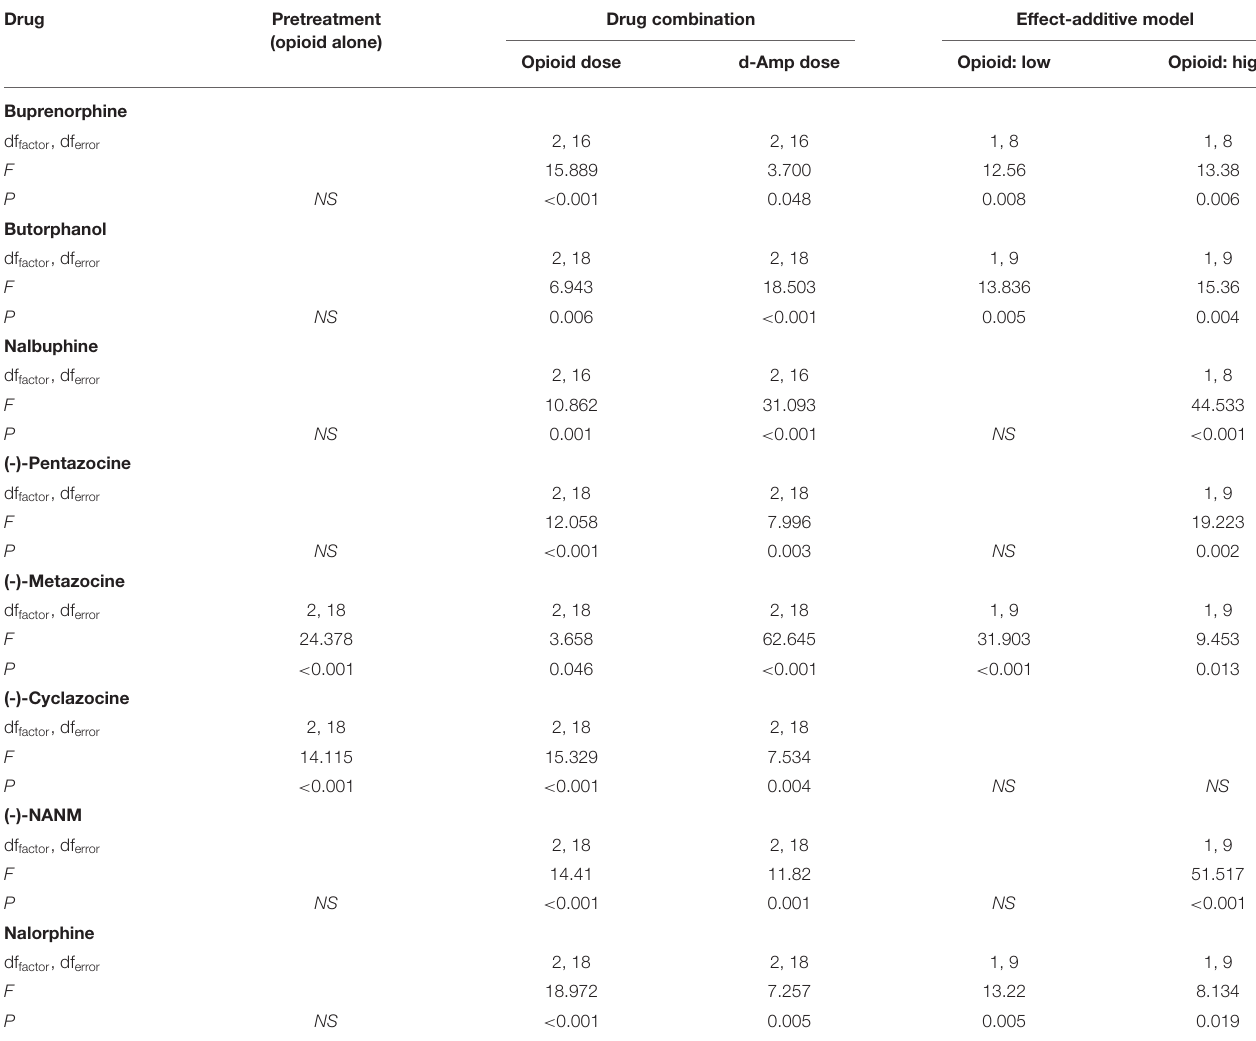
TABLE 2 | ANOVA table for intermediate-efficacy opioids. Drug Pretreatment Drug combination Effect-additive model (opioid alone) Opioid dose d-Amp dose Opioid: low Opioid: